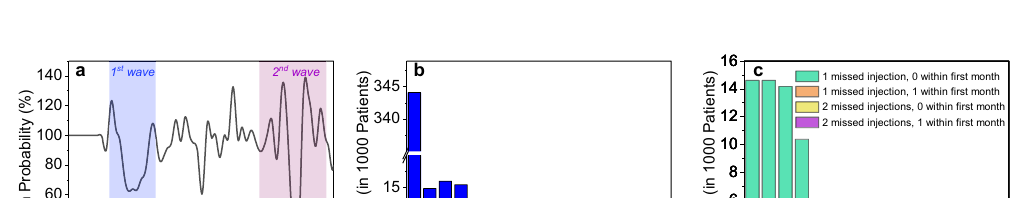
Figure 5. Effect of undertreatment and loading period. Mean BCVA change from baseline with 95% prediction interval in a scenario with 3l-q8w pattern (green), a scenario with 3 q4w loading injections followed by equally spaced maintenance injections (purple) and a scenario without loading injections with injections equally spaced throughout the observation time (blue). In the purple and blue scenario, the total number of injections, treatment delay and baseline characteristics are as in OCEAN in both scenarios. BCVA = best corrected visual acuity.